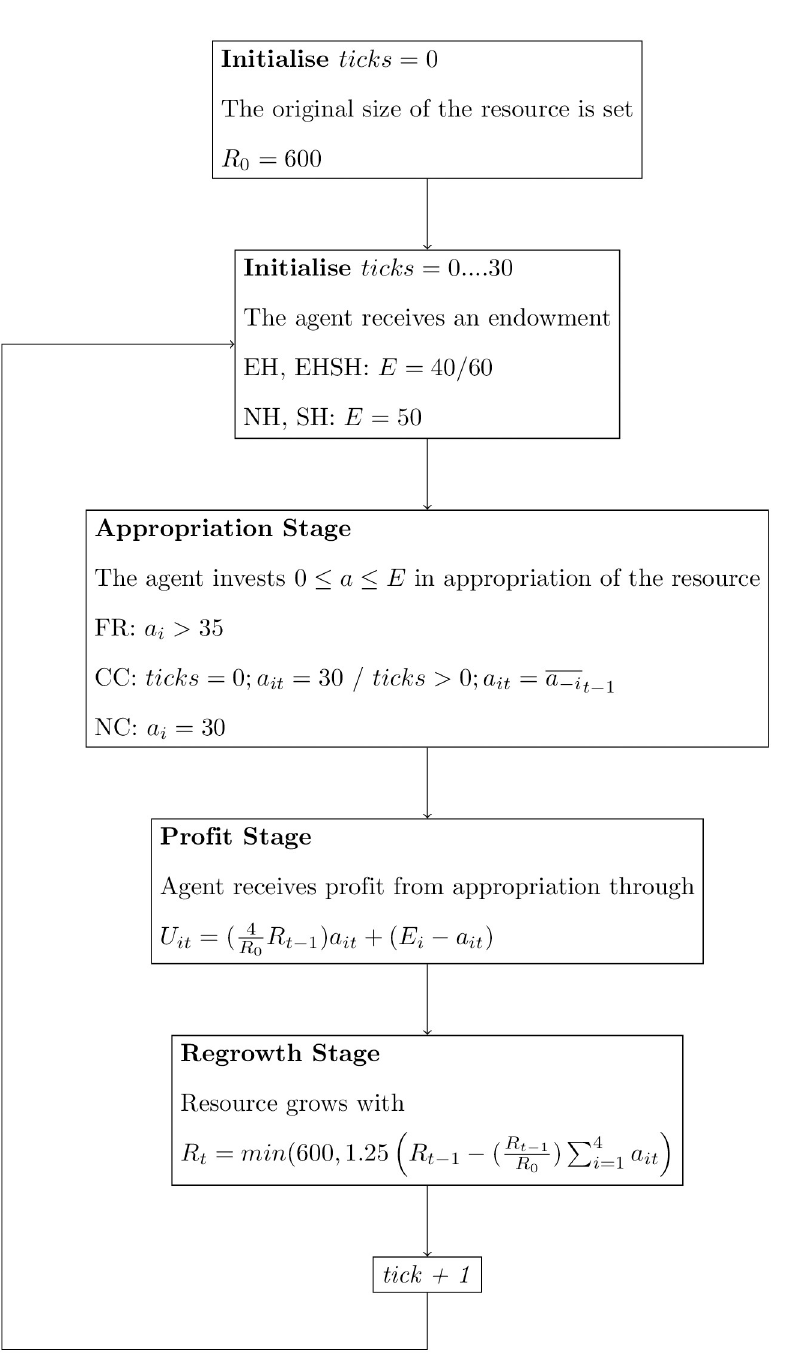
Fig 2. A flow chart overview of the mixed ABM model as coded in NetLogo [57].